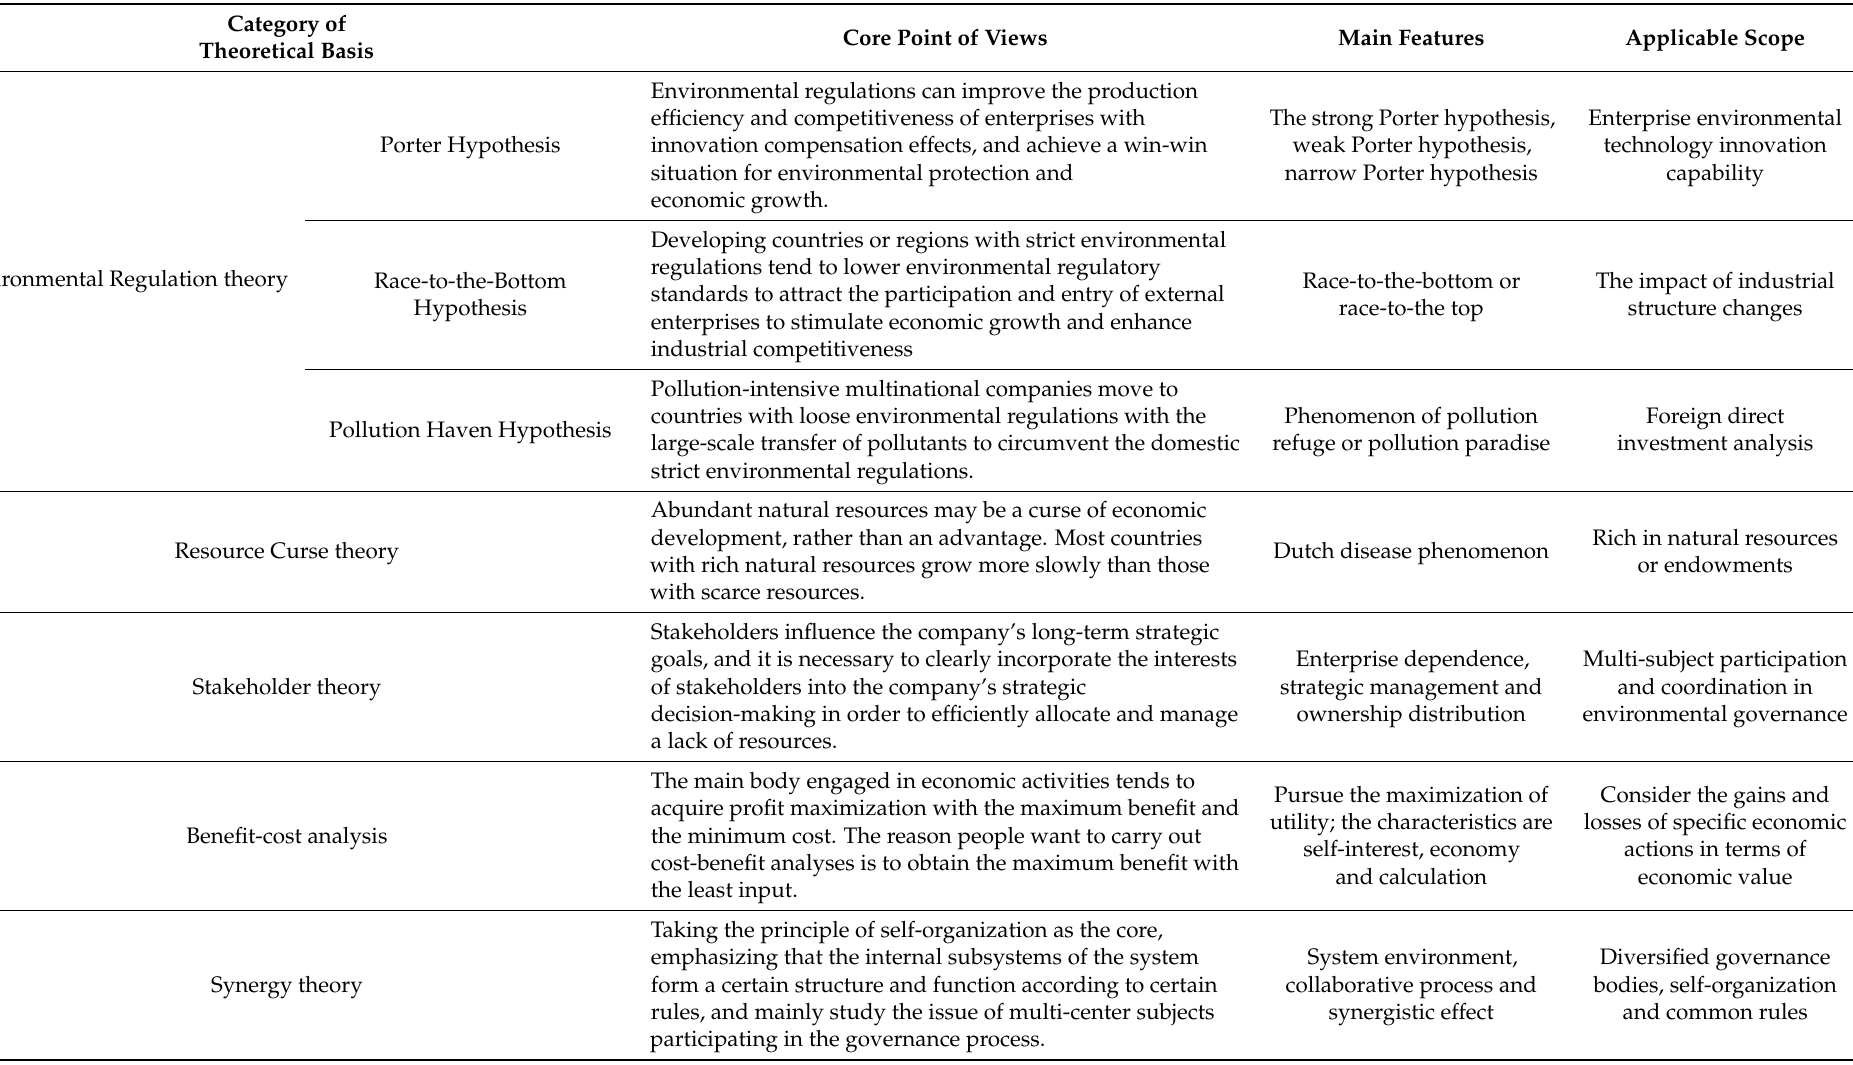
Table 3. Summary of mainstream theoretical bases of studies on haze pollution